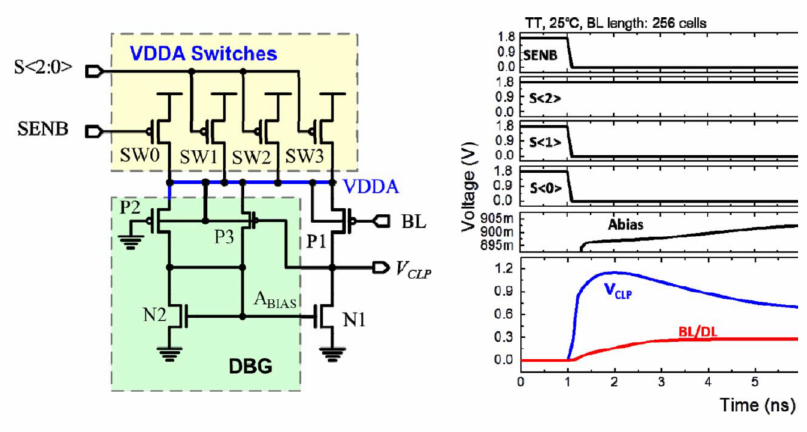
Figure 21. The structure and simulation of PTFA [76]. The BLPSE (BL precharge speed enhancement) scheme is used to reduce the charge time of the BL, without affecting the sensing margin, shown in Figure 22. In the initial stage of charge, a large current is generated on BL (to charge parasitic capacitance), and it is copied to MP2, then the voltage of NSA1 is raised, the MCRG transistor is turned on, and the charging speed of BL accelerates. After BL reaches the target value, the current decreases. The voltage of node NSA1 drops. The MCRG transistor is turned off.